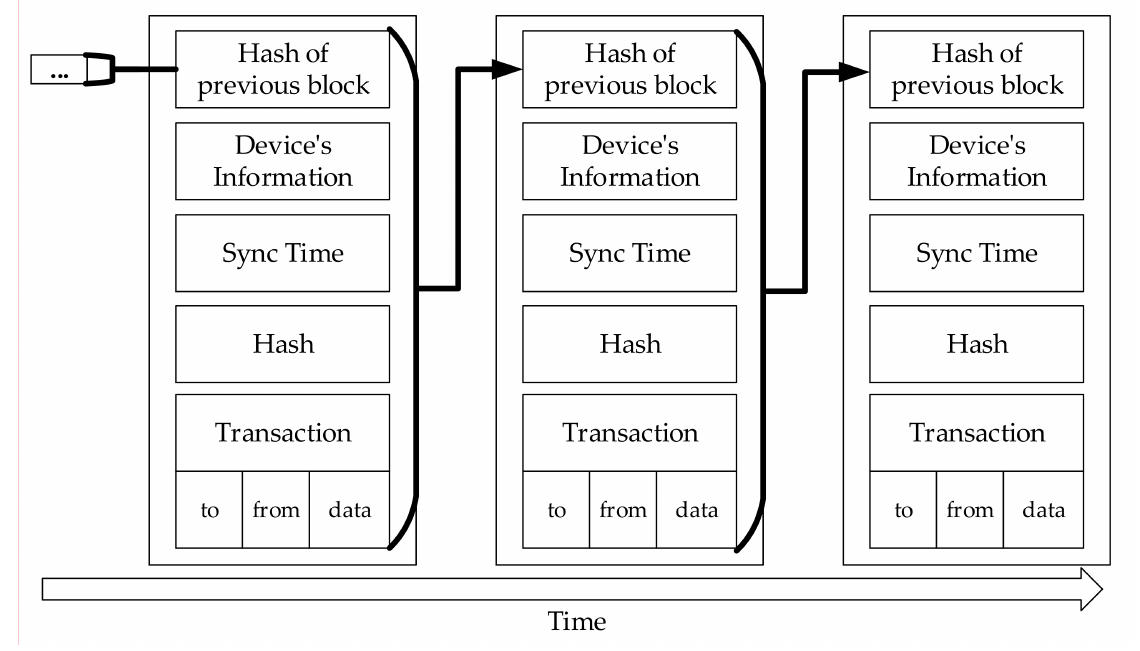
Figure 4. An example block for the normal sensed data blockchain. Table 2. A synchronization and integration transfer stage